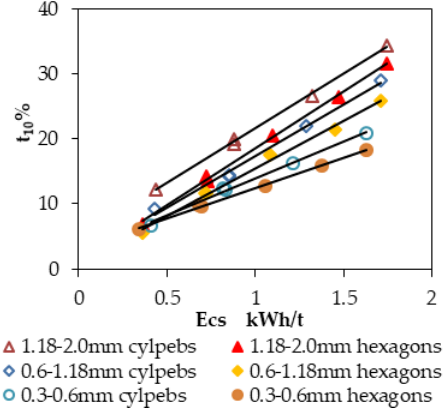
Figure 6. t 10 in relation to specific energy.